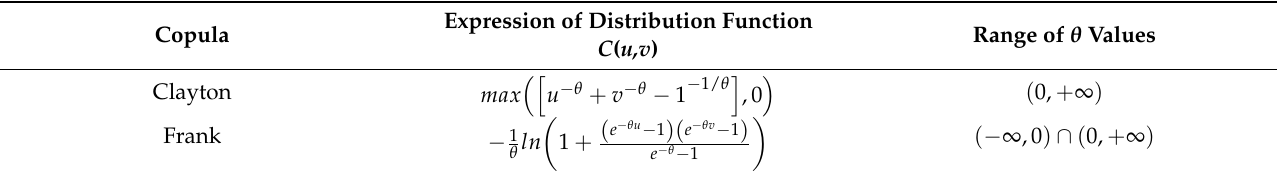
Table 1. Expressions of marginal distribution